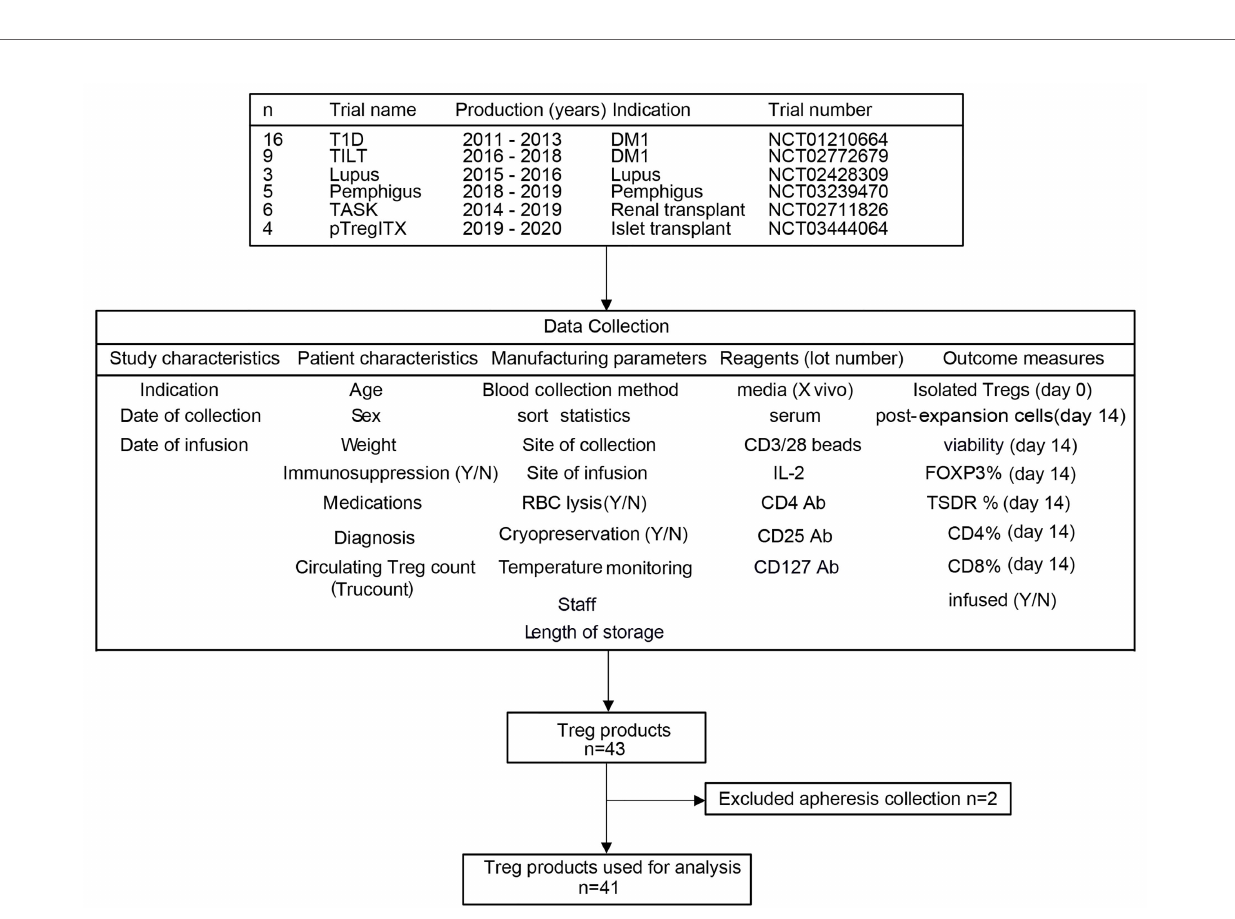
FIGURE 2 | Study diagram. Schematics of PolyTreg clinical trials, data collection, and